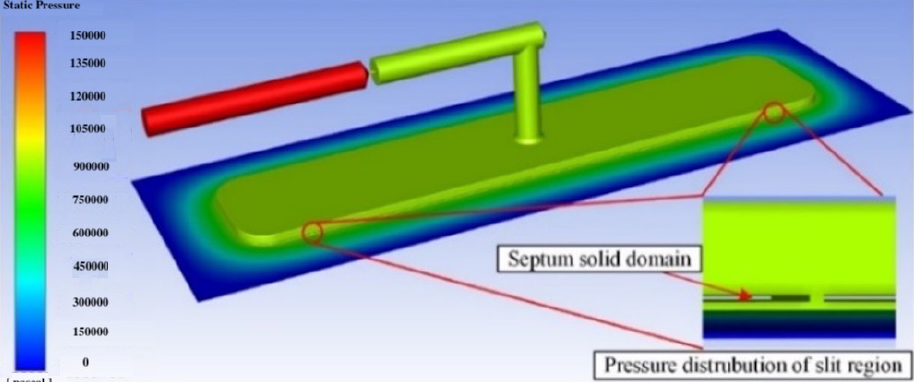
Figure 14. Pressure distribution of the bearings at rest after optimization (film thickness h = 20 µ